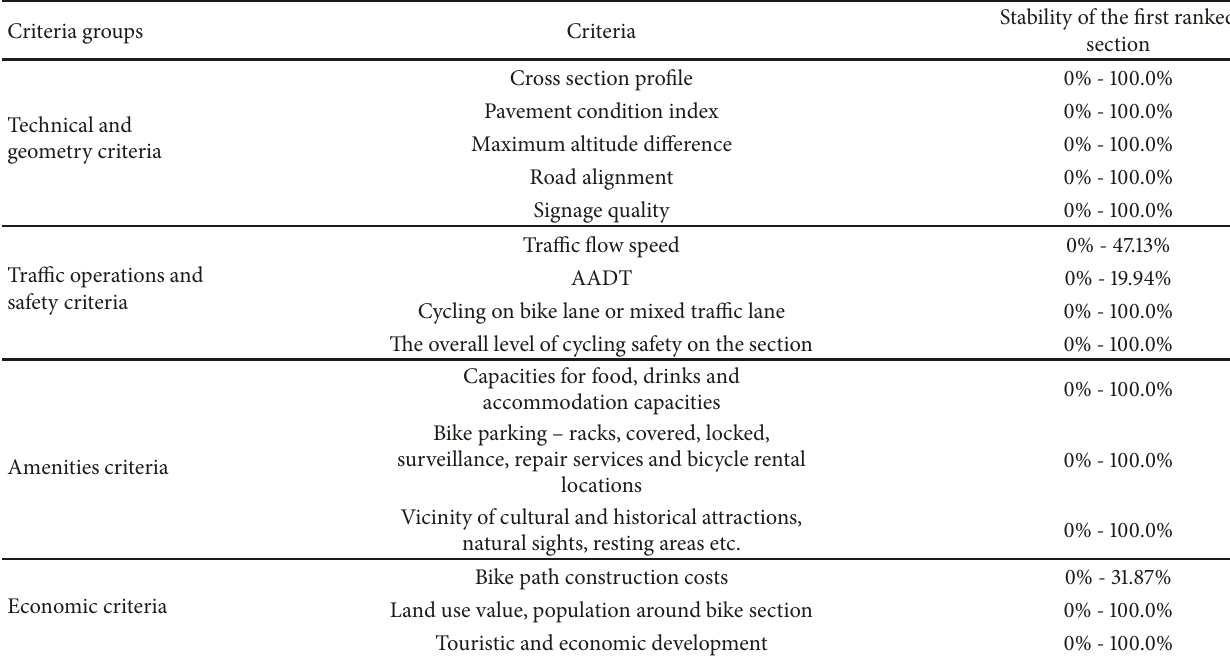
Table 6: Analysis stability of the first place for all sections of EuroVelo 8 route through Montenegro. Criteria